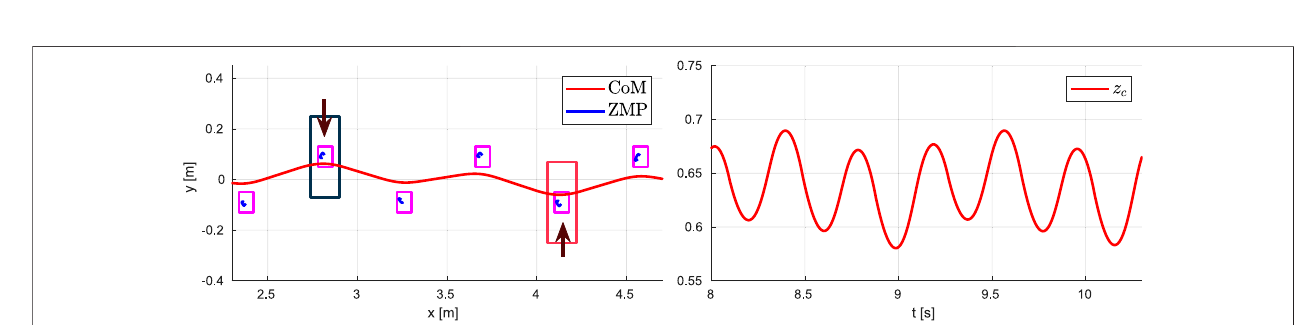
FIGURE17| Runningovertiltedsurfaces.CoM/ZMPtrajectories(left)andCoMheight(right).Theplotsonlyrefertotheportionofthesimulationbeforeandafterthe twotiltedsurfaces(represented asrectanglesintheCoM/ZMPplots).Theblackarrow represents theequivalentdisturbance causedbythetangentialcomponent ofthe gravity when stepping on the tilted patch.